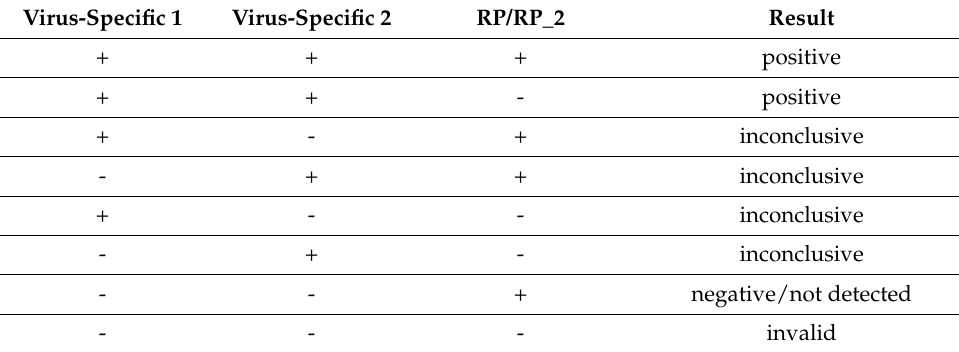
Table 3. Data analysis and interpretation. Virus-Specific